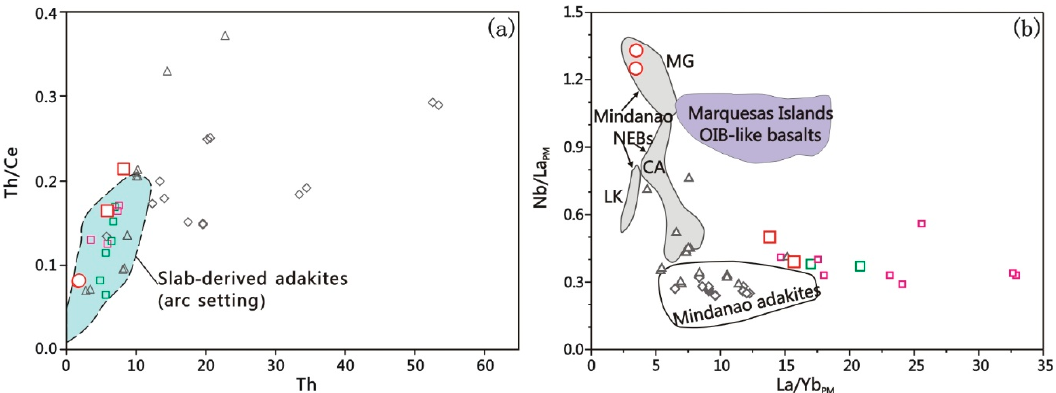
Figure 11. ( a )Th/Ce versus Th diagram and ( b ) （ Nb/La ） PM versus （ La/Yb ） PM diagram. The fields Figure 11. ( a ) Th / Ce versus Th diagram and ( b ) (Nb / La) PM versus (La / Yb) PM diagram. The fields for for Mindanao adakites, NEBs, and Marquesas Islands OIB ‐ like basalts are from [82]. The data sources Mindanao adakites, NEBs, and Marquesas Islands OIB-like basalts are from [82]. The data sources and and symbols are as in Figure 6. symbols are as in Figure